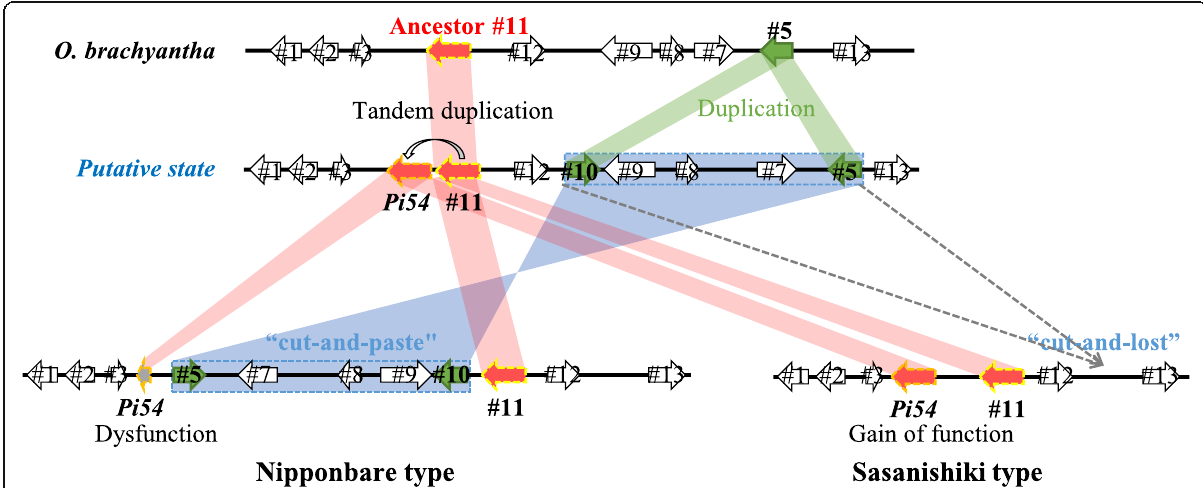
Fig. 7 Model of the evolution of the two types of Pi54 locus. In particular, the Pi54 allele in Sasanishiki has lost its function because of several SNPs and small insertions and deletions. Dashed rectangle represents the mobile